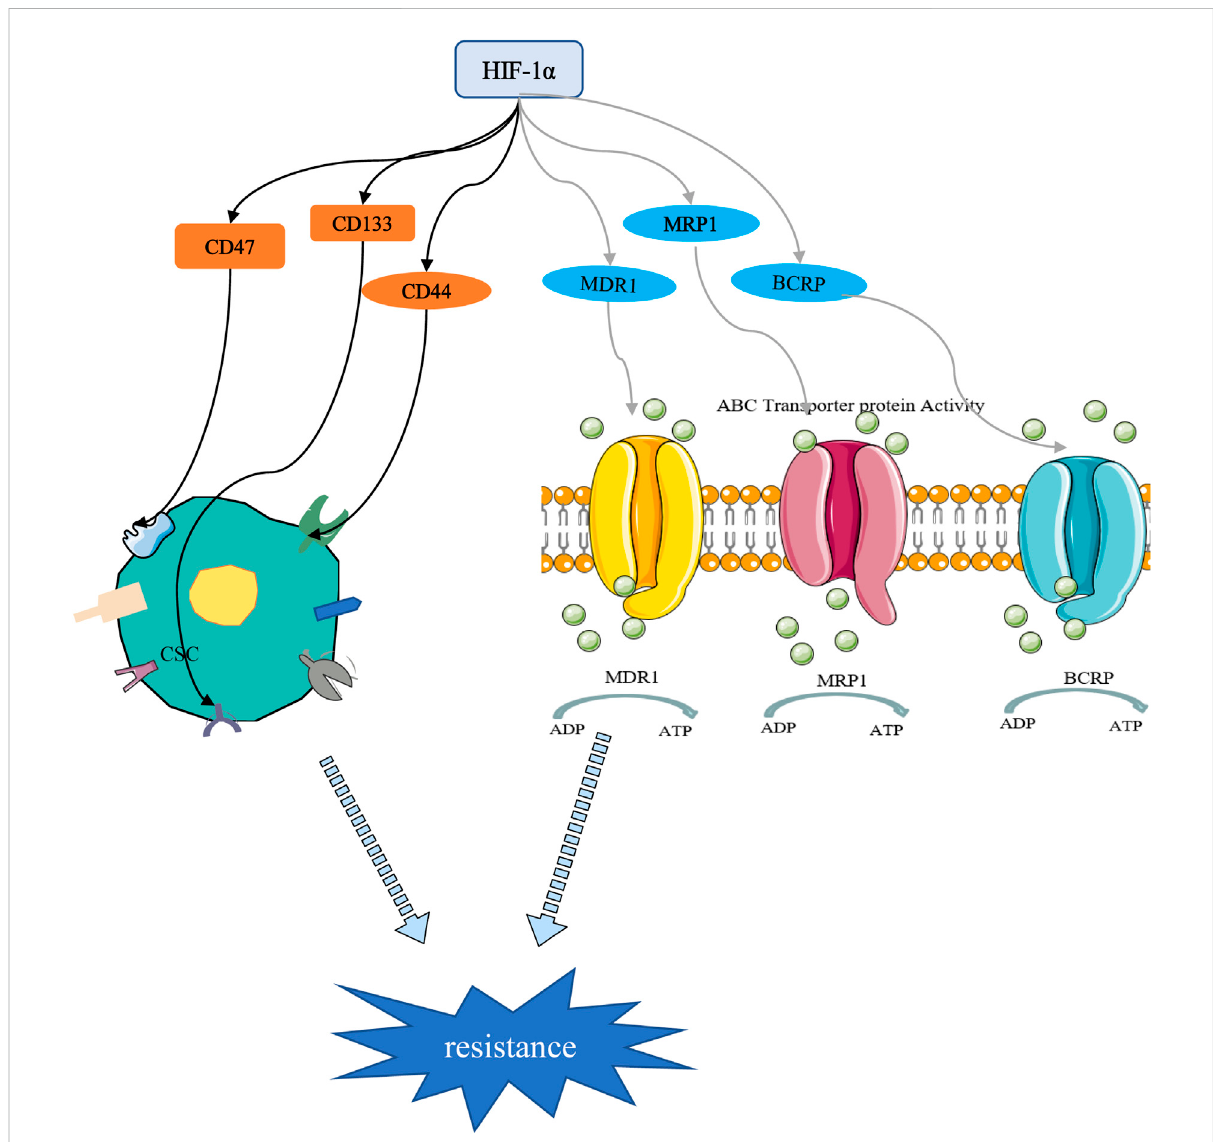
FIGURE 5 HIF-1 α -mediated stemness and drug resistance. On the one hand, HIF-1 α can induce drug resistance by regulating stem cell surface markers. On the other hand, HIF-1 α promotes chemotherapy resistance through drug resistance-related